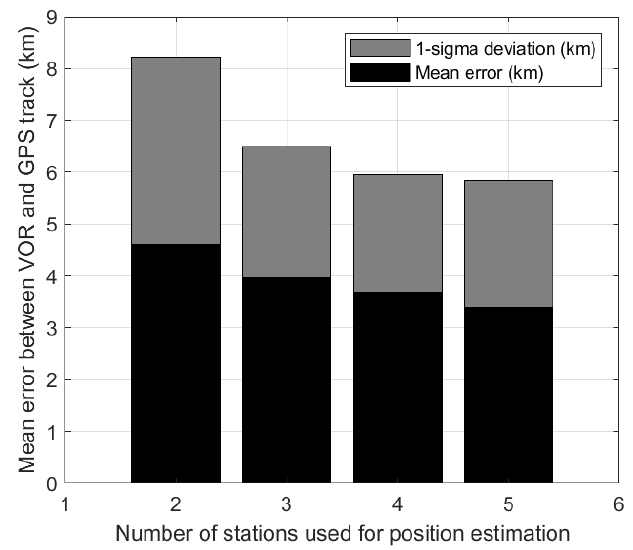
Figure 8. Trend of the mean error and deviation of the position estimation depending on how many VOR stations were used.